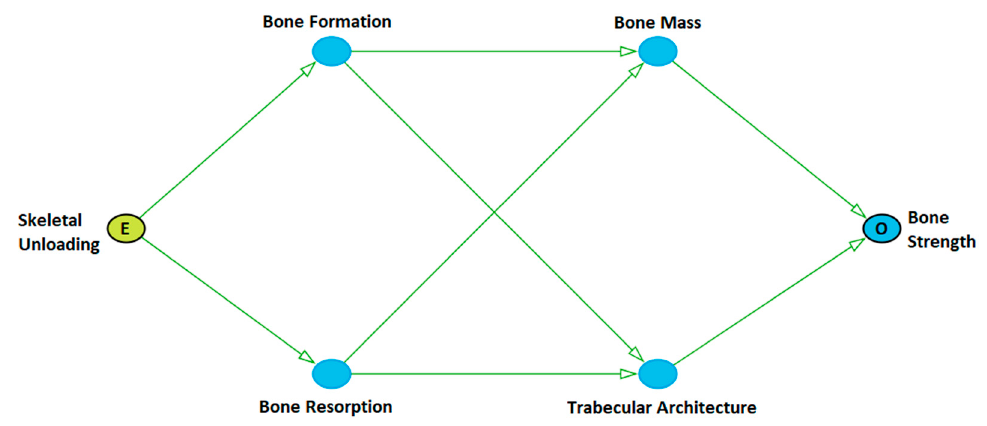
Figure 1. Causal diagram (in DAG form) showing the causal pathways between skeletal unloading and bone strength. Table 2. Marginal correlations and their expected directions of association.